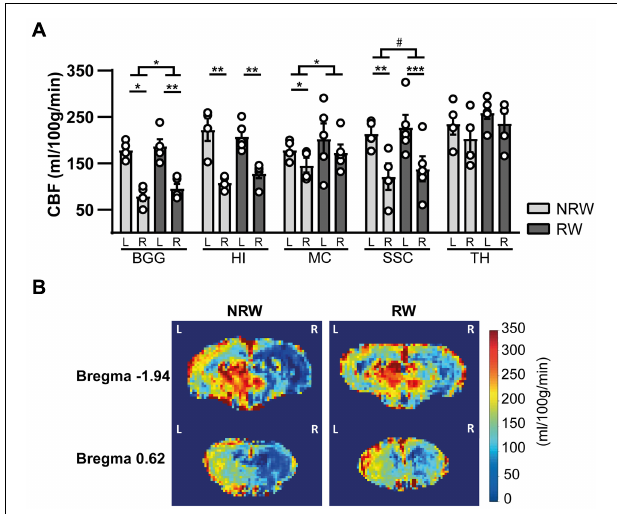
FIGURE 5 | (A) Cerebral blood flow (CBF) 6 days after stroke induction assessed in different ROI (BGG: Basal ganglia, HI: Hippocampus, MC: Motor cortex, SSC: Somatosensory cortex) of running wheel (RW) and no running wheel (NRW) mice. (B) Representative high-resolution voxel-wise CBF images of two different bregma’s (–1.94 and 0.62) that were assessed in the NRW and RW group. RW: N = 5, NRW: N = 4; values represented in mean ± SEM. # 0.05 < p < 0.08 (tendency); * p ≤ 0.05; ** p ≤ 0.01; *** p ≤ 0.001.